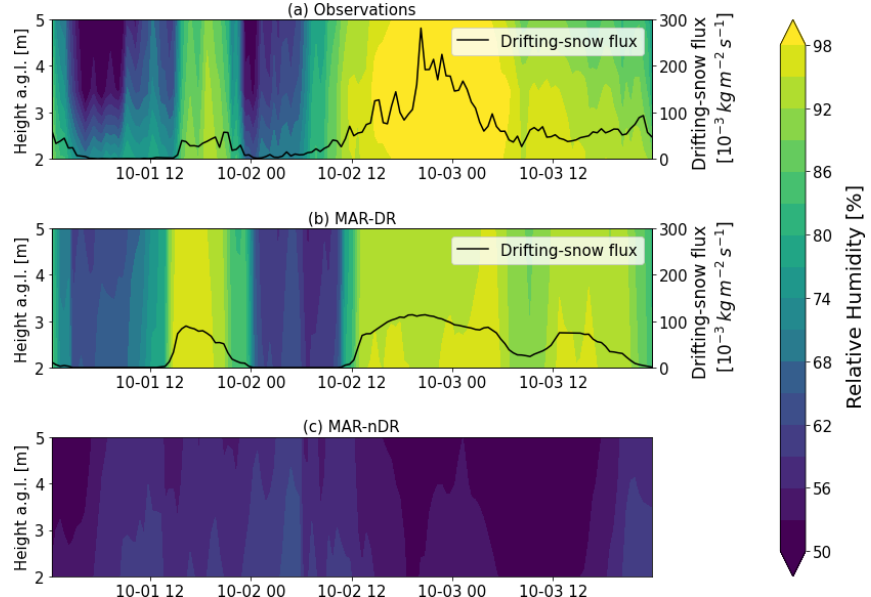
Figure 2. (a) Observed, (b) MAR-DR, and (c) MAR-nDR vertical relative humidity profile (with respect to ice; color) and drifting-snow fluxes (from the surface to 2ma.g.l.; black line) between 1 and 3 October